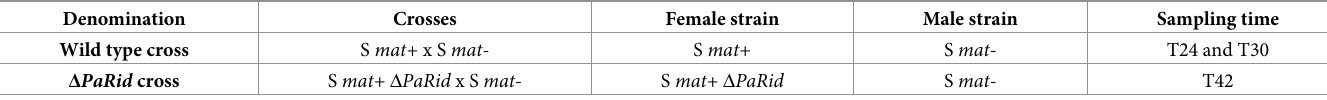
Table 3. Crosses used in transcriptome